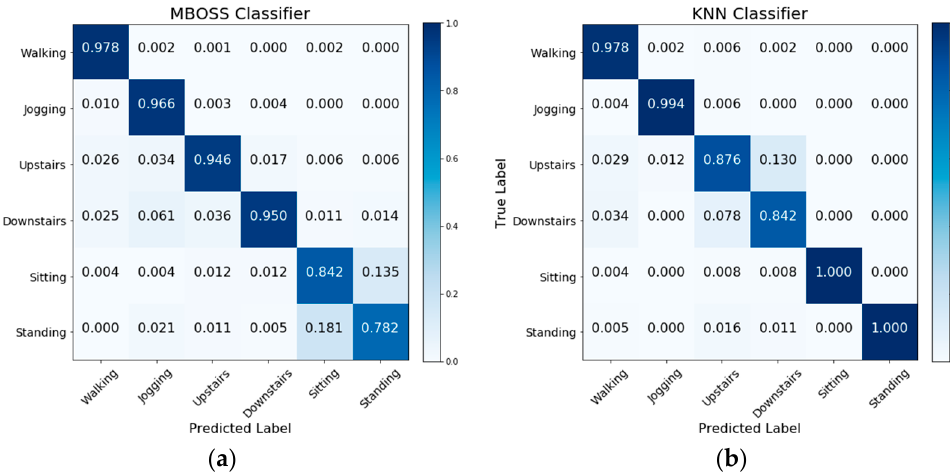
Figure 7. Confusion matrices for ( a ) MBOSS and ( b ) KNN classifiers for the WISDM dataset.